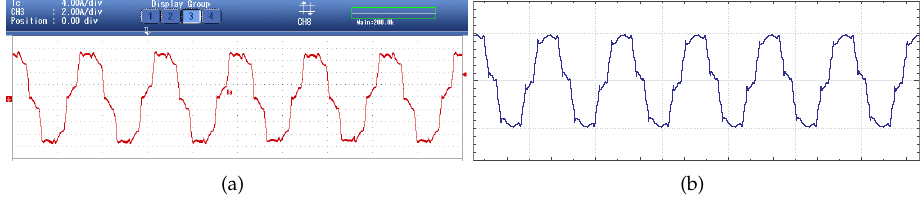
Figure 22. Grid current waveform for Case 5, THD = 15.1%: ( a ) measured current; ( b ) simulated current.